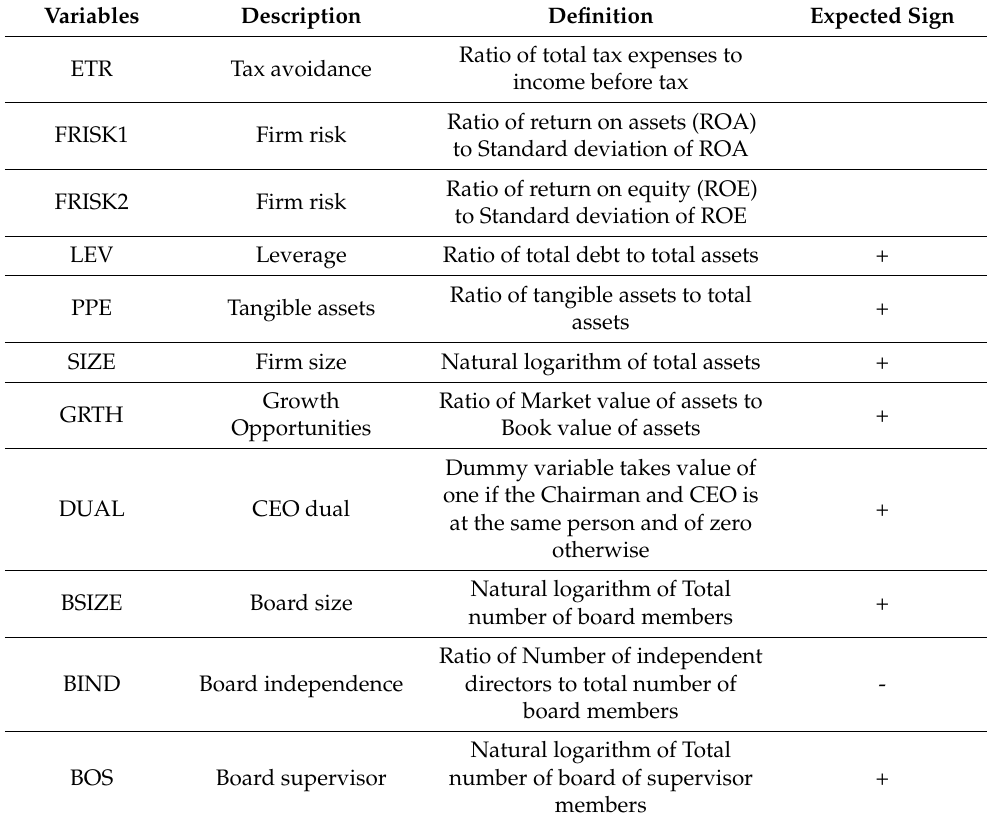
Table 2. Variables’ abbreviation, description, definition and expected